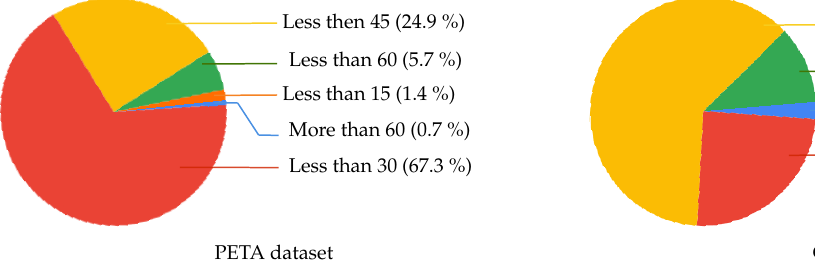
Figure 4. Frequency distribution of the labels describing the ‘Age’ class in the PETA [152] (on the left ) and CRP [162] (on the right )